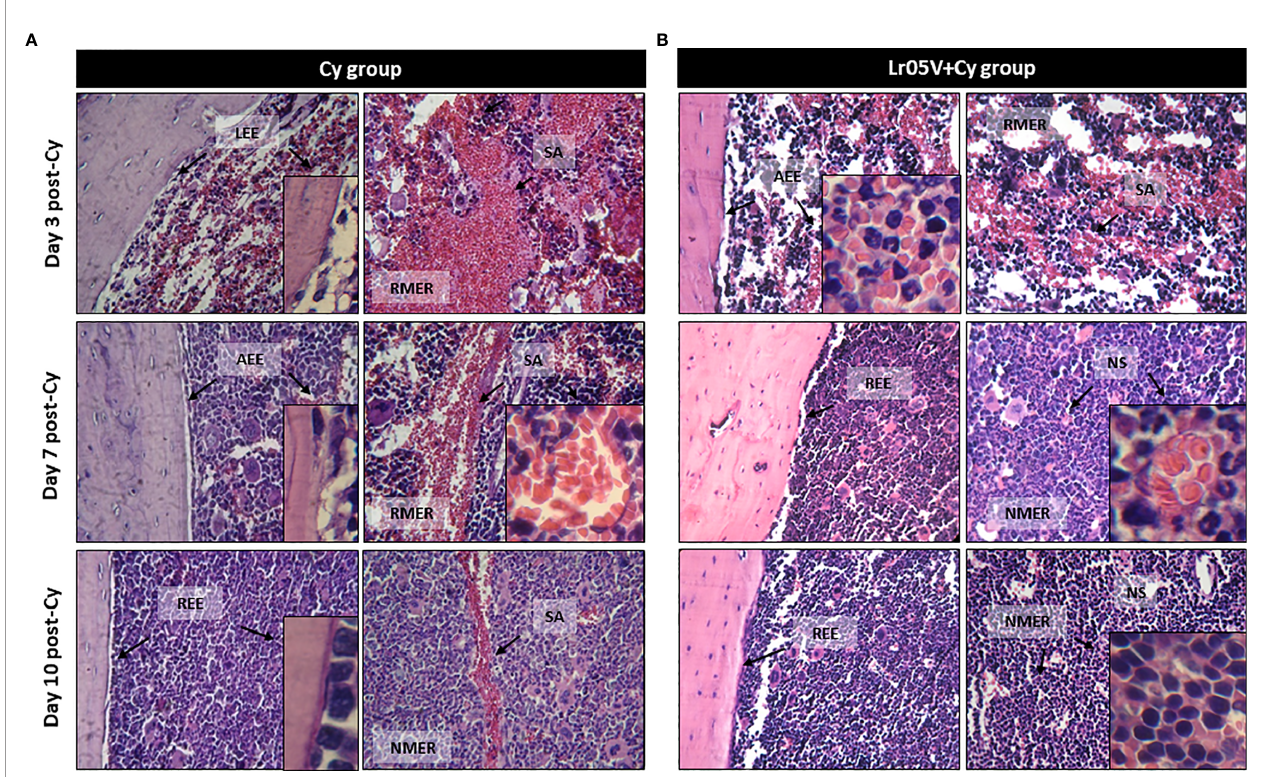
FIGURE 2 | Histological examination of bone marrow architecture. The femurs were removed from control mice (Cy group) (A) , and mice treated with viable Lactobacillus rhamnosus (Lr05V+Cy group) (B) on days 3, 7 and 10 post-Cy administration. The samples were fi xed in paraformaldehyde, decalci fi ed in formic acid and sodium citrate, stained with hematoxylin and eosin and examined with a light microscope (400× and 1000× magni fi cation). The results represent data from two independent experiments. Six animals were used for each time point by groups. LEE, Loss of endostal epithelium; AEE, altered endostal epithelium; REE, recovered endostal epithelium; RMER, reduced myeloid/erythroid ratio; NMER, normal myeloid/erythroid ratio; SA, sinusoidal alteration; NS, normal